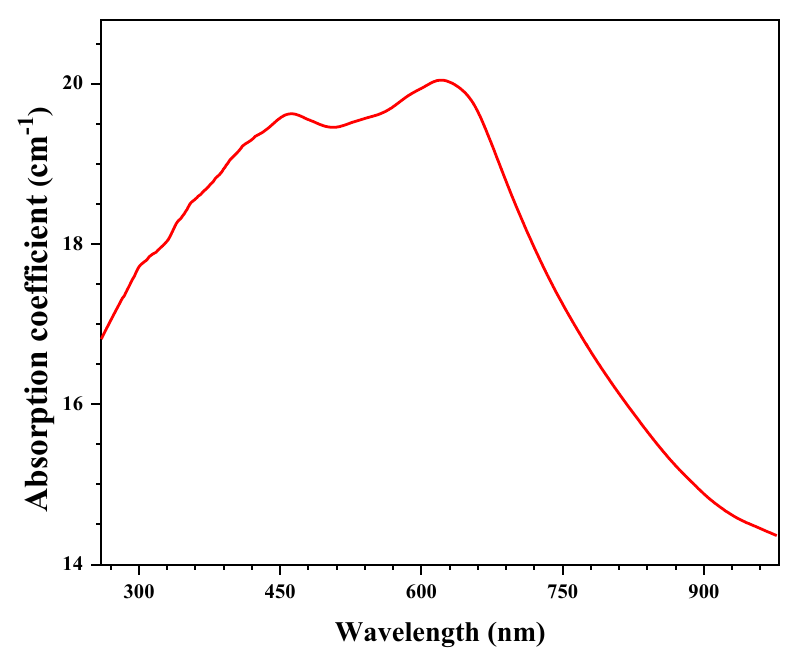
Figure 6. Absorption coefficient as function of wavelength of synthesized Se NPs.